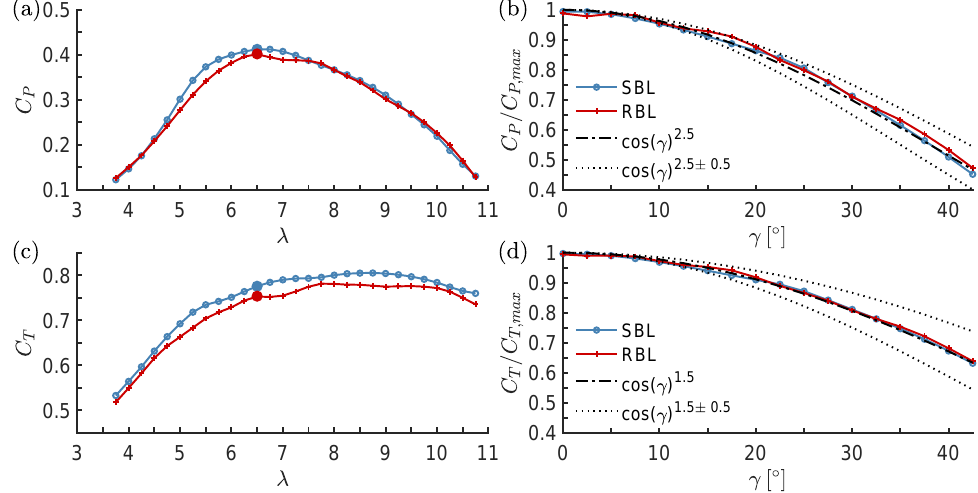
Figure 6. ( a , c ) Power and ( b , d ) thrust coefficients C P and C T as function of tip-speed ratio λ and yaw angle γ for constant chord based Reynolds number ¯ Re c = 62,500. The legend states the flow conditions. For the coloured points hot wire measurements were